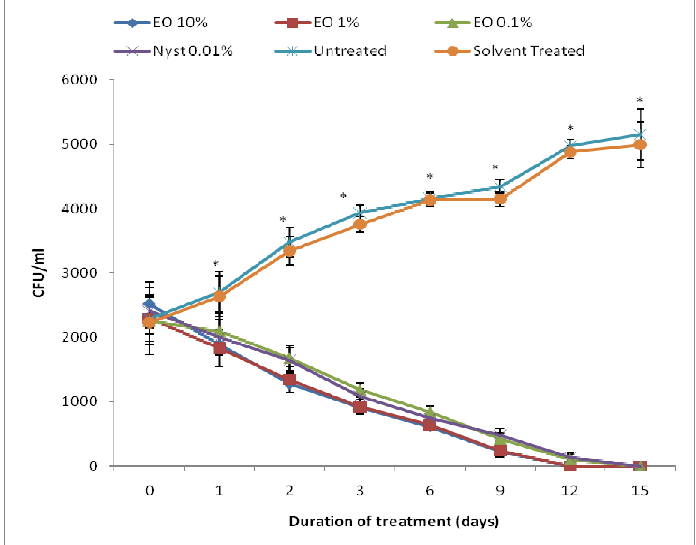
Figure 2. Evolution of healing effect of the essential oil of C. ambrosioides on vaginal candidiasis model in rat as a function of oil